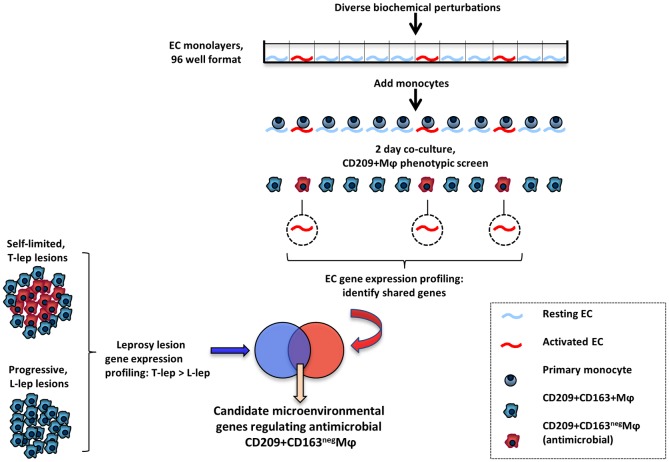
Overview of experimental design.After identification of unique activators of endothelium-directed MΦ differentiation (top), transcriptomes from activated endothelium were compared to the leprosy transcriptome to identify potential regulators of anti-microbial MΦ differentiation at the site of disease.